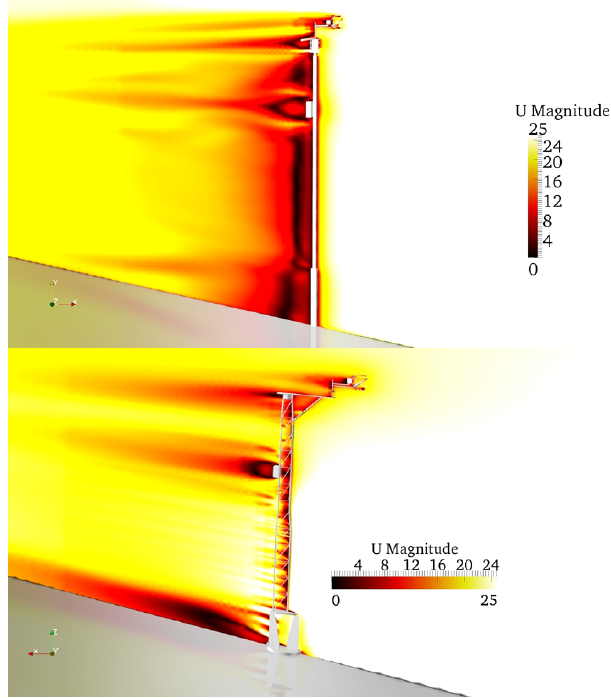
Fig. 11. Modelled velocities for each of the two masts for an input velocity of 25ms − 1